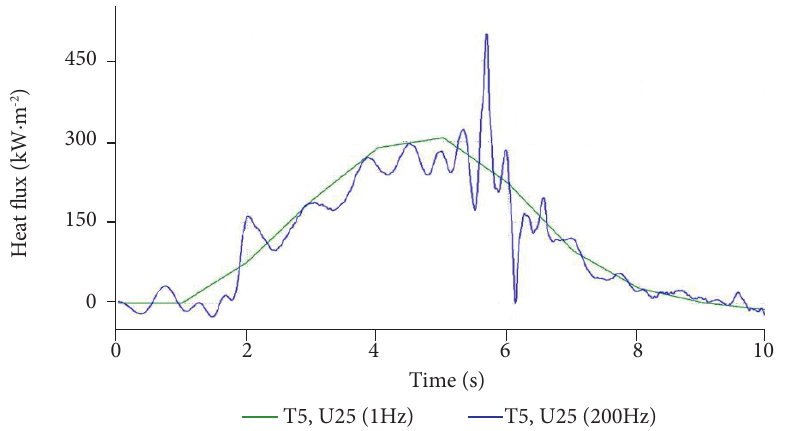
Figure 14. Heat flux from temperature history of thermocouple T5, of U25 and